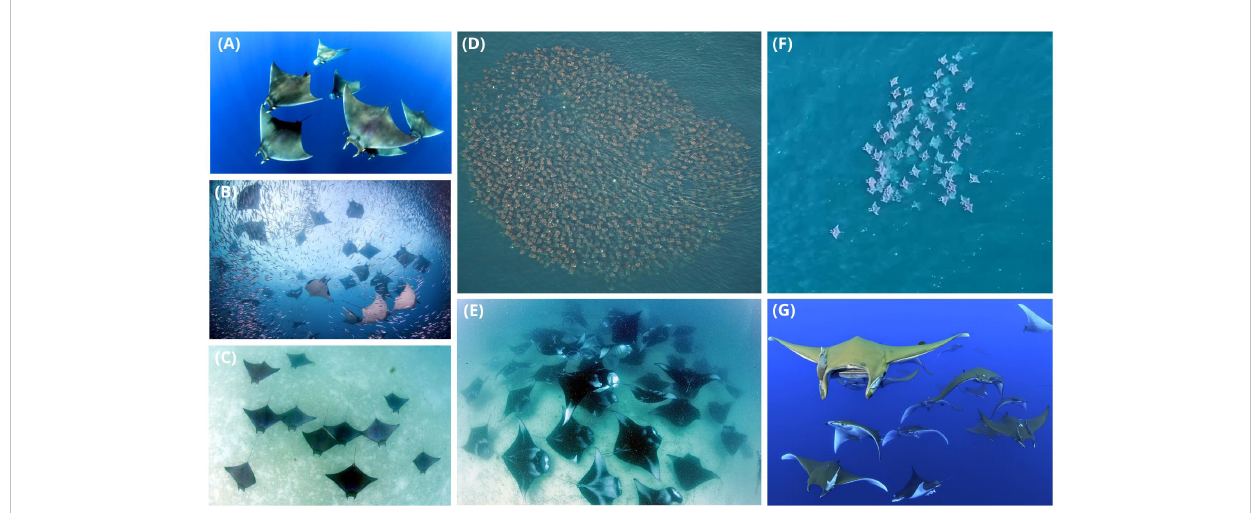
FIGURE 3 Mobulid aggregations. (A) M. hypostoma in the Mexican Caribbean. Photo © Guy Stevens. (B) A feeding aggregation of M. eregoodoo at Raja Ampat, Indonesia. Photo © Jeff Lemelin. (C) M. kuhlii aggregation in the Maldives. Photo © Guy Stevens. (D) M. munkiana aggregating in the Gulf of California, Mexico. Photo © Sidharta Velázquez-Hernández, Ocean Life Flights. (E) M. alfredi during a cooperative feeding aggregation in Hanifaru Bay, Maldives. Photo © Guy Stevens. (F) Aggregation of M. mobular in the Gulf of California, Mexico. Photo © Sidharta Velázquez-Hernández, Ocean Life Flights. (G) M. tarapacana at Princess Alice Banks, Azores. Photo © Tane